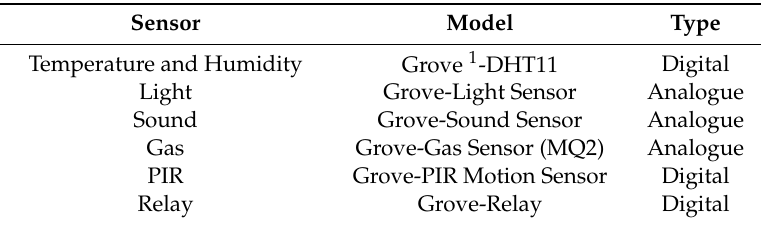
Table 3. Sensors and actuator used in this project.